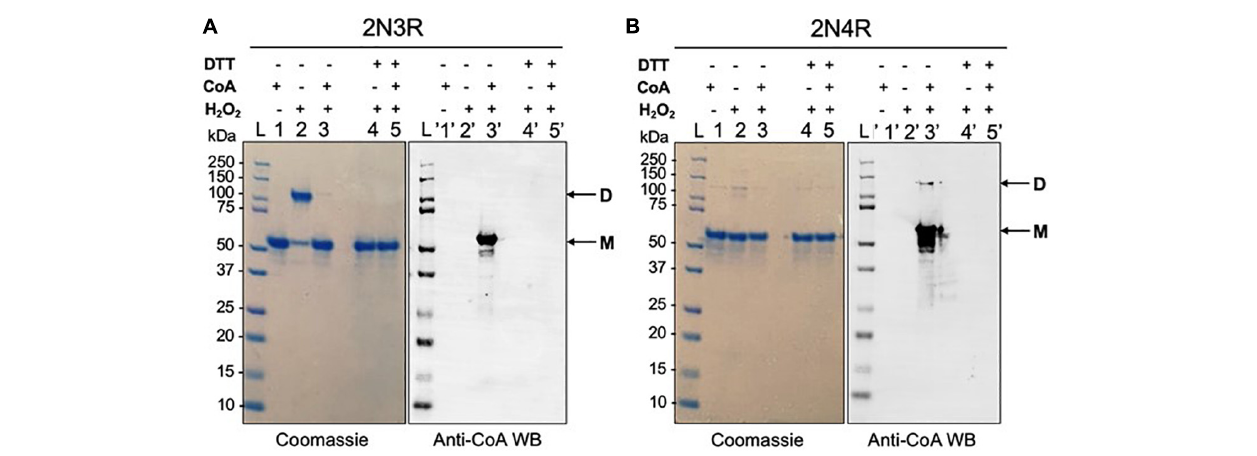
FIGURE 4 | H 2 O 2 -induced dimerization of 2N3R tau isoform is inhibited by CoAlation. (A) H 2 O 2 -treatment of 2N3R tau causes its dimerization (Lane 2 – D). In the presence of CoA and H 2 O 2 , 2N3R becomes in vitro CoAlated (Lane 3 (cid:48) ), and its dimerization is inhibited (Lane 3 – M). In the presence of DTT, both dimerization and CoAlation of 2N3R tau are inhibited (Lanes 4, 4 (cid:48) , 5 and 5 (cid:48) – M). (B) H 2 O 2 -treatment of 2N4R tau shows only a minor dimerization band (Lane 2and 2 (cid:48) – M and D), probably due to the formation of intramolecular disulfide bond formation, rather than an intermolecular disulfide formation. H 2 O 2 and CoA-treated 2N4R tau shows CoAlation (Lane 3 (cid:48) – M and D). In the presence of DTT, CoAlation is absent (Lane 5 (cid:48) ). Lane L represents the molecular weight marker, and lane 1 represents the reduced form of 2N3R and 2N4R tau isoforms in the presence of CoA, where CoAlation is not observed (Lane 1 (cid:48)